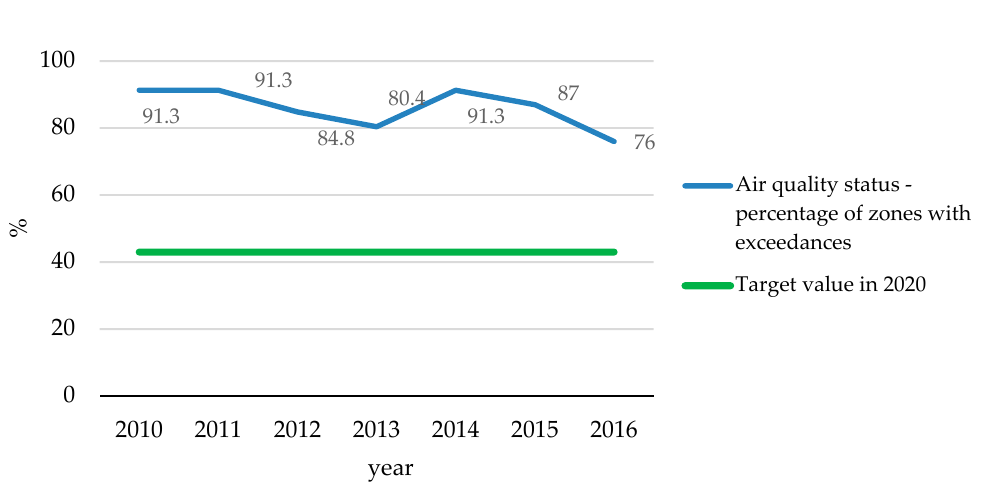
Figure 1. Air quality status in Poland—percentage of zones with exceedances.